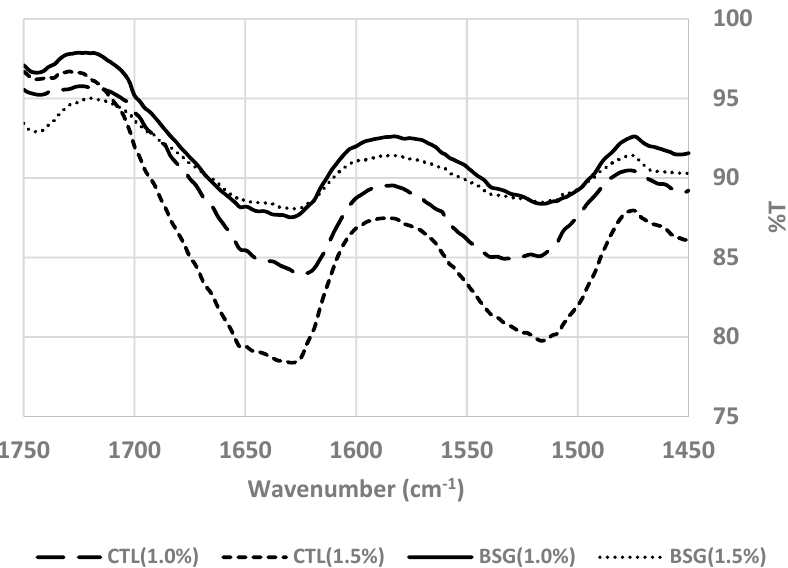
Figure 6. FTIR (wavenumber 1750–1450 cm − 1 ) of low-fat sausages with basil seed gum at different salt levels. Treatments: CTL(1.0%), sausage without basil seed gum (BSG) at 1.0% salt concentration; CTL(1.5%), sausage without BSG at 1.5% salt concentration; BSG(1.0%), sausage with BSG at 1.0% salt concentration; BSG(1.5%), sausage with BSG at 1.5% salt concentration.